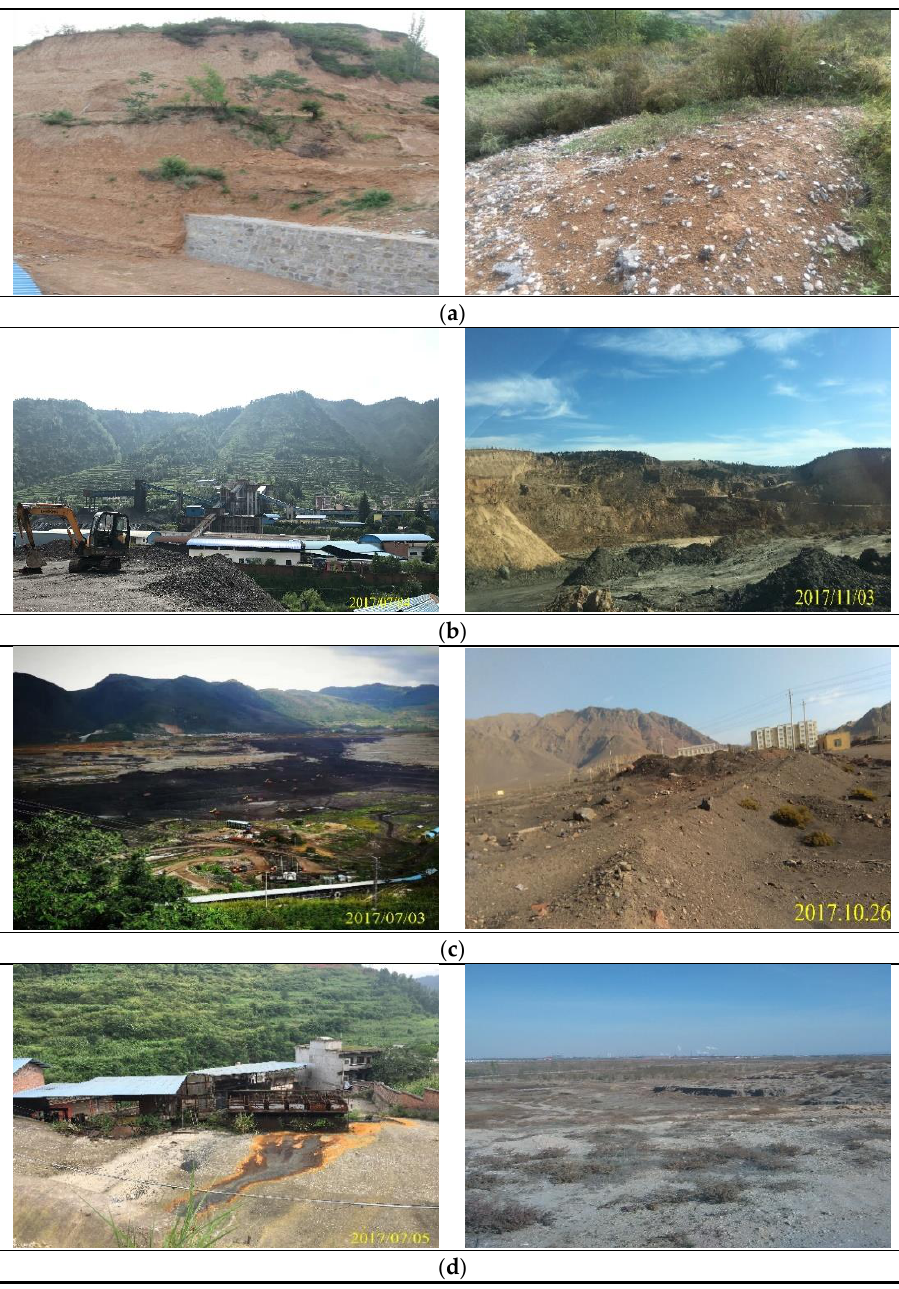
Figure 2. The field survey typical pictures of the western region. Shaanxi xunyao mining area ( a ), Guizhou pan county mining area, and Inner Mongolia Pingzhuang mining area ( b ), Yunnan xiaolongtan mining area, and Xinjiang tuha mining area ( c ), Sichuan gushi mining area, and Ningxia lingwu mining area ( d ).